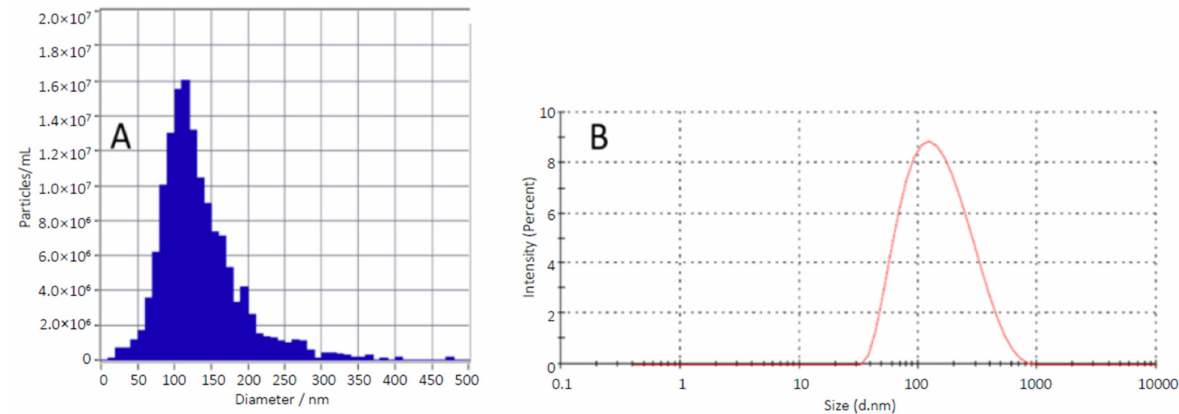
Figure 2. The size and size distribution of berberine (BBR)-loaded liposomes generated by the ethanol-injection method (FJ12): ( A ) The particle size distribution of liposomes (by number of particles per ml) analyzed with ZetaView ® NTA; ( B ) The size distribution (by intensity) analyzed with Zetasizer Nano ZSP.